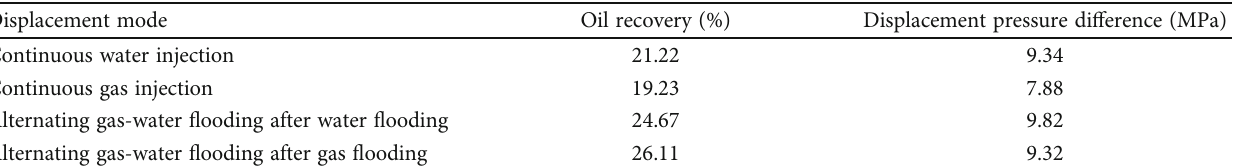
Table 2: Statistical table of oil recovery and displacement pressure di ff erence under di ff erent displacement modes.